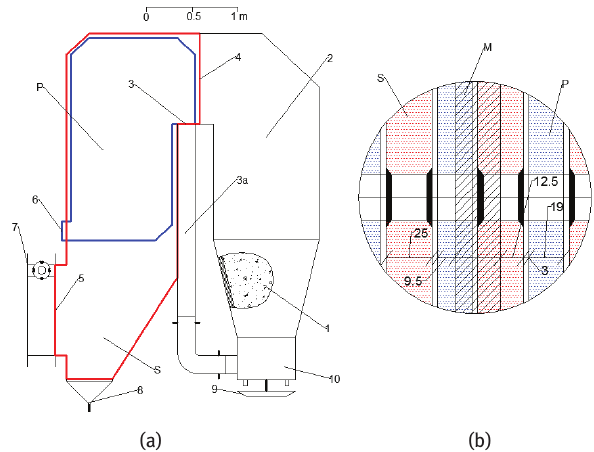
Figure 1: The modelled system: a) The fluidised bed furnace with heat exchanger b) Heat exchanger details: M – control